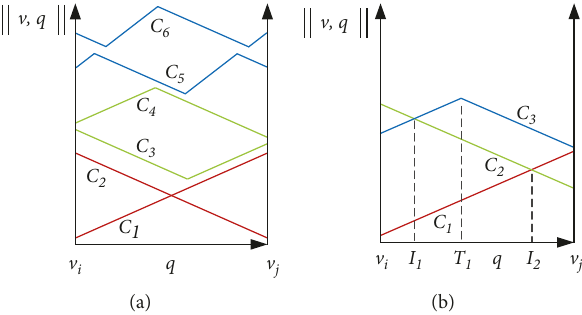
Figure 10: Illustration of distance function. (a) Distance curve. (b) Event